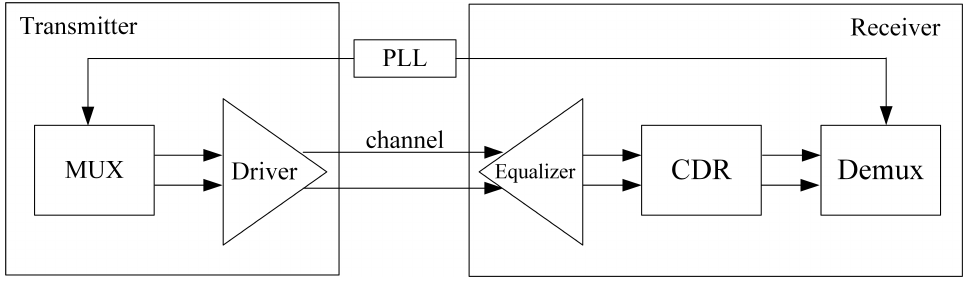
Figure 1. SerDes system block